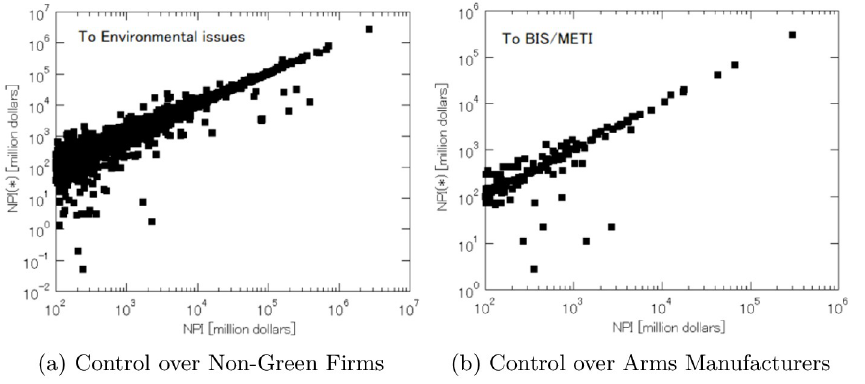
Fig 6. How much equity funds inflate market influence over non-ESG